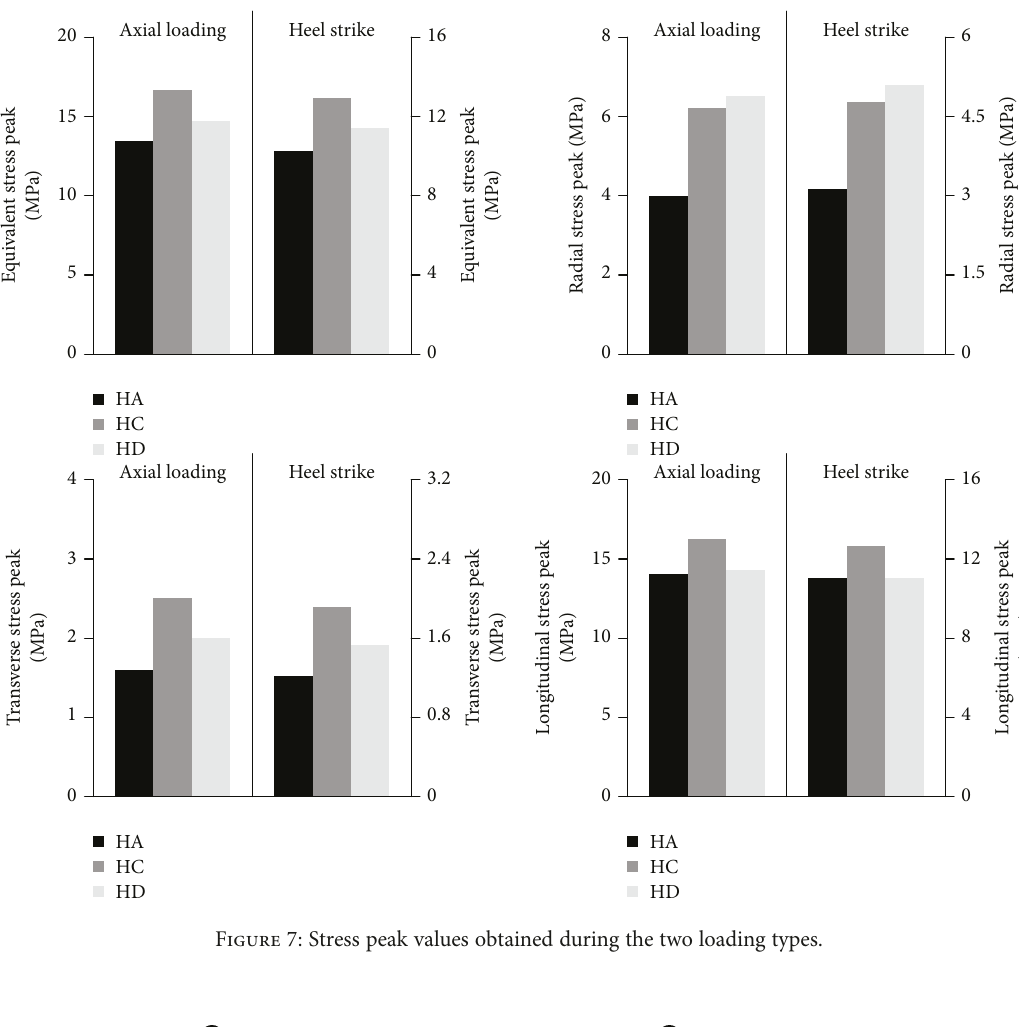
Figure 7: Stress peak values obtained during the two loading types.